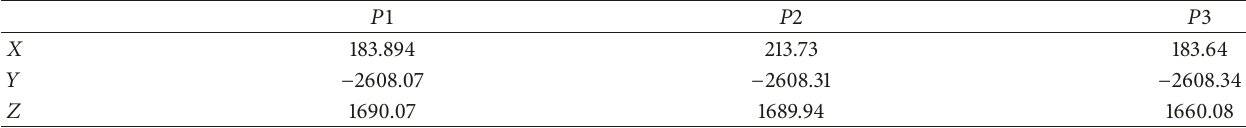
Table 8: Coordinates of base holes in robot coordinate system before changing coordinate